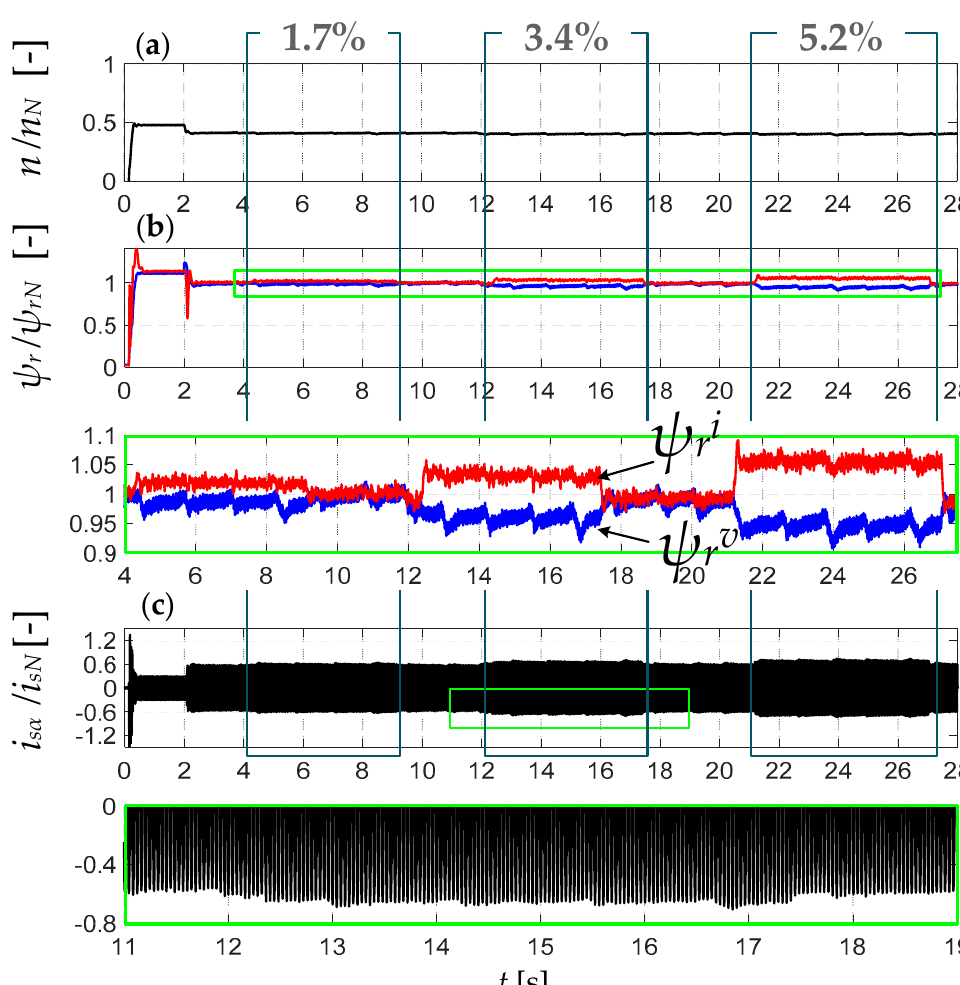
Figure 14. Operation of open-loop control scheme (v / f ) during ITSC: ( a ) measured rotor speed, ( b ) estimated rotor flux, ( c ) measured stator current in phase A; (experimental results), ( n ref = 0.5 n N , T l = 0.5 T N ).